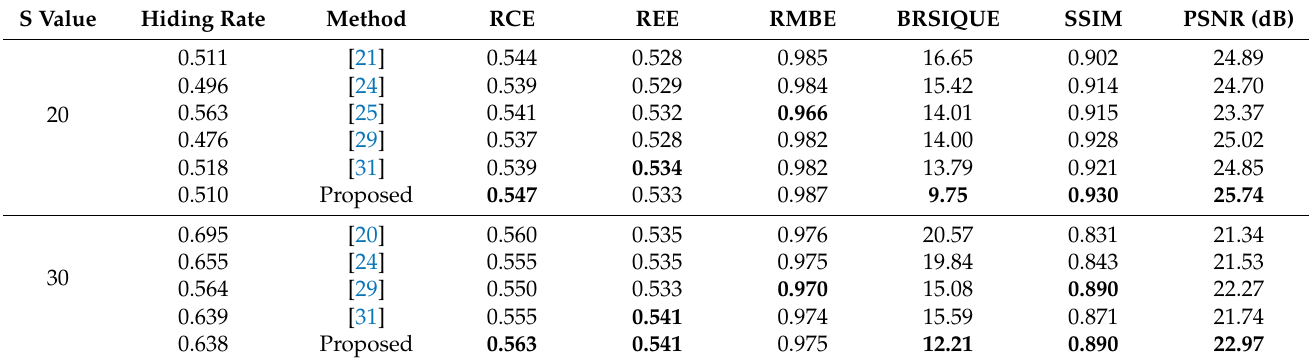
Table 6. Average metrics with Kodak dataset using F , C = 1 for BS embedding.